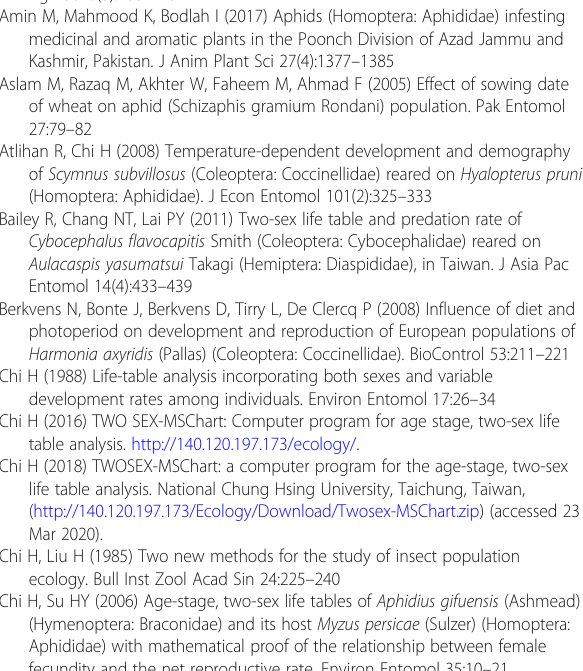
table parameters of Hippodamia variegata (Coleoptera: Coccinellidae) fed on Aphis gossypii (Hemiptera: Aphididae) under laboratory conditions. ISRN Entomol 2013:1 – 7 Dixon AFG (2000) Insect predator – prey dynamics: Ladybird beetles and